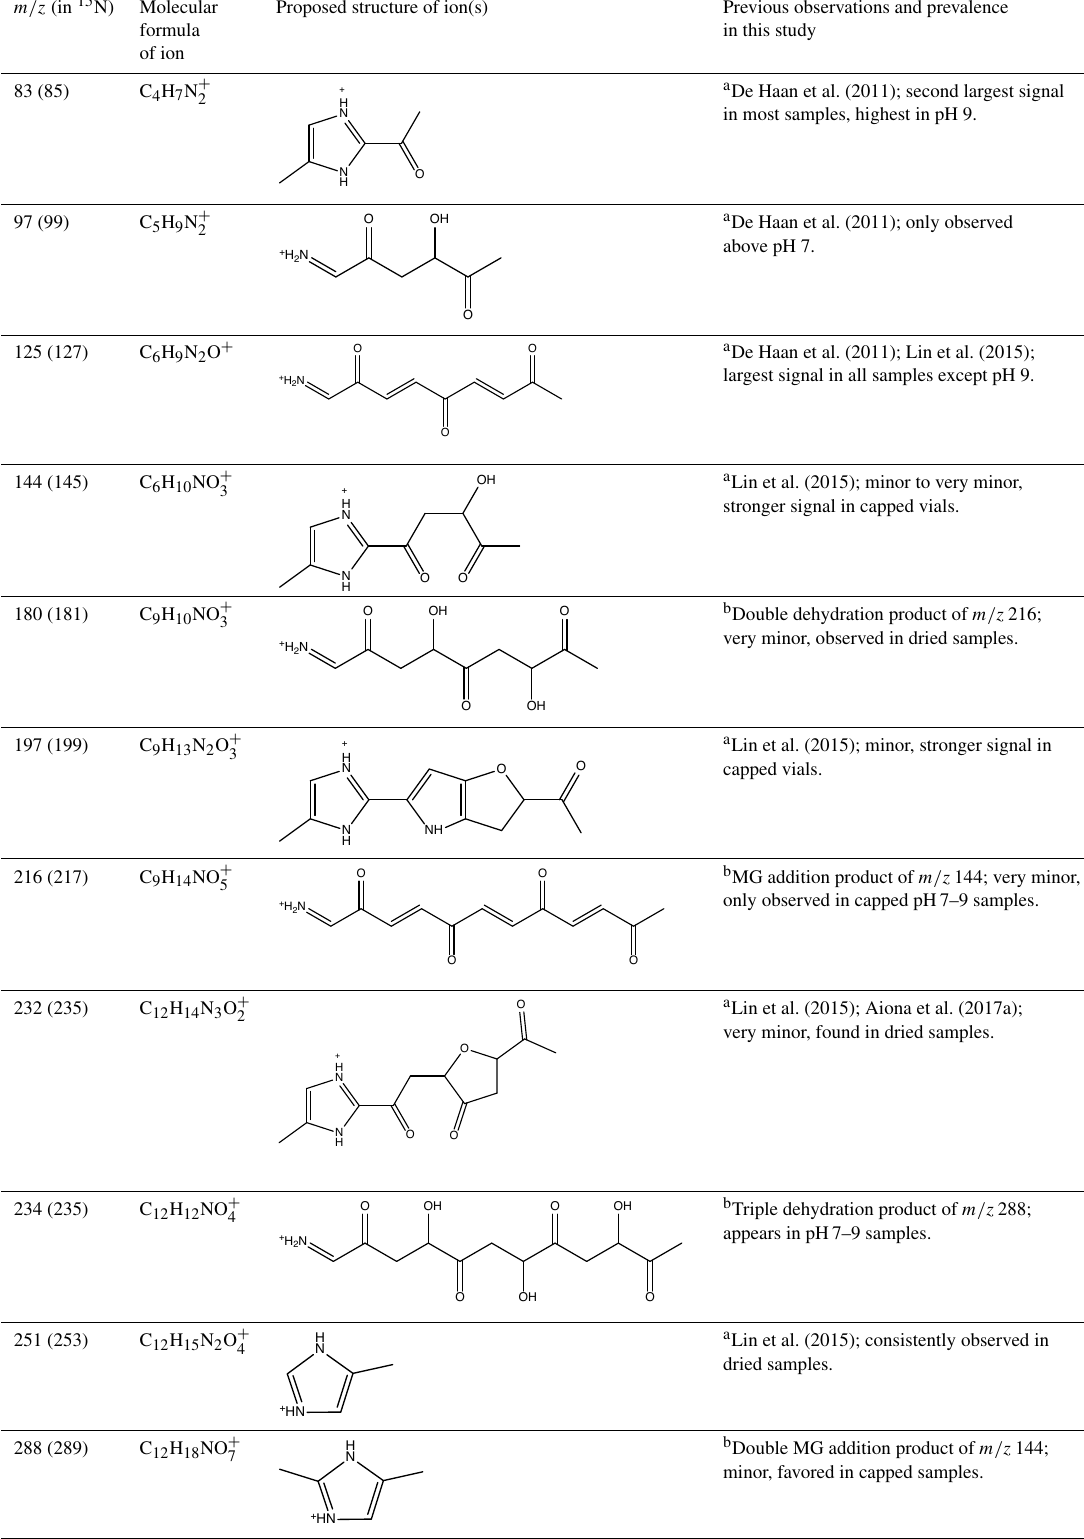
Table 2. Proposed structures for products detected by APCI-MS that are either (a) previously reported or (b) analogs of previously reported compounds. In the case of type (a) compounds, citations are provided. The observed m/z in 15 N samples are provided in parentheses. m/z (in 15 N) Molecular Proposed structure of ion(s) Previous observations and prevalence formula in this study of